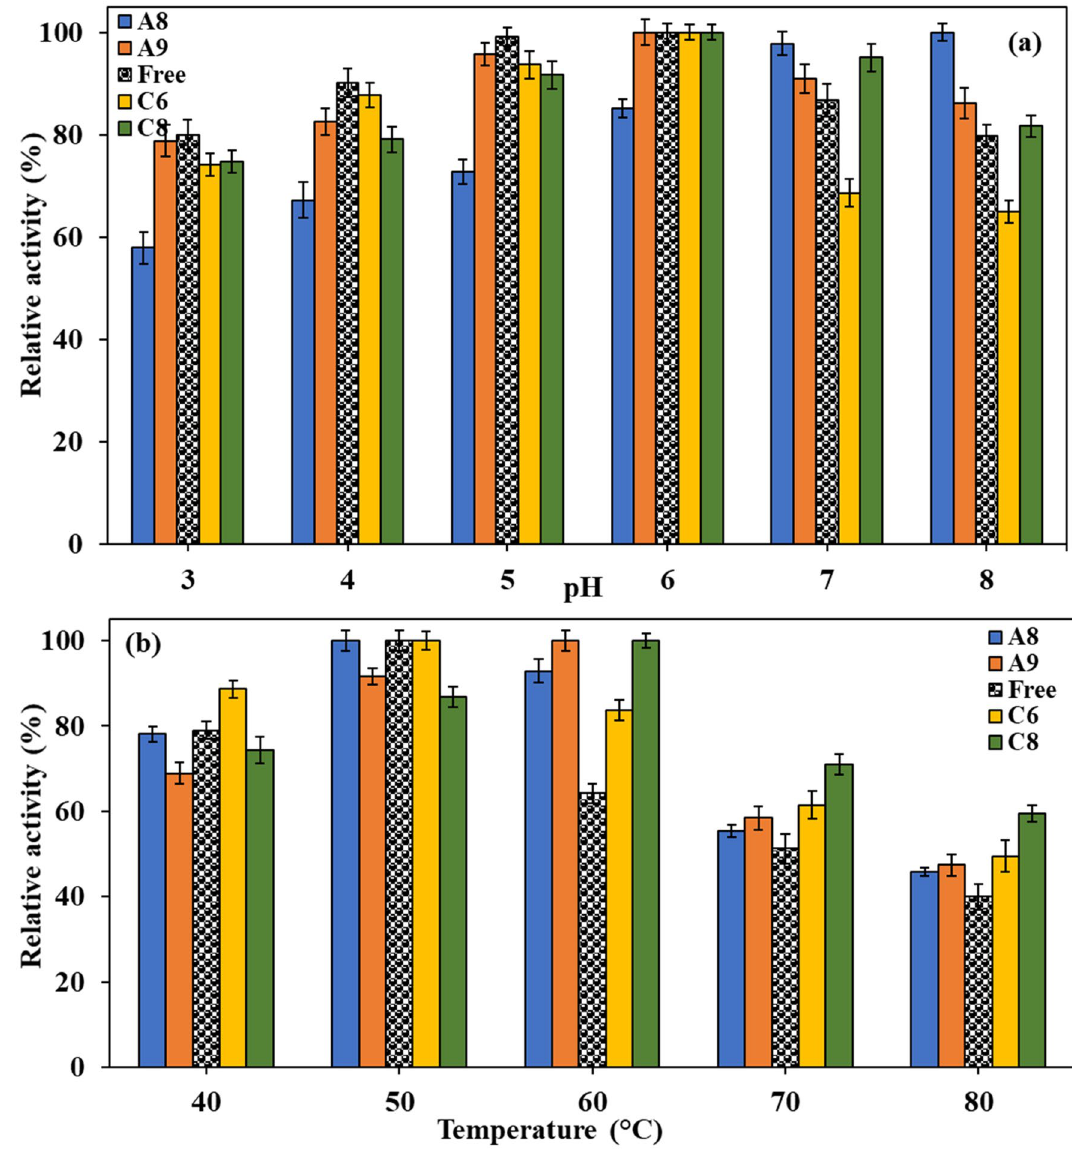
Figure 6. Effect of ( a ) pH and ( b ) temperature on the activity of the free and immobilized PersiXyn9 on the selected hydrogel